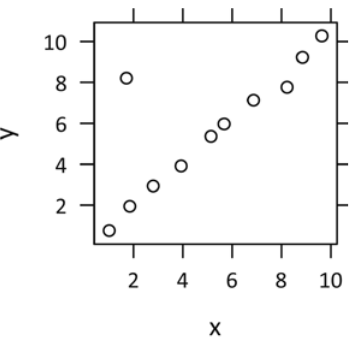
Figure 2 - A bivariate outlier: a value that is not atypical for the distributions of variables x and y considered separately, but is atypical for their bivariate distribution.